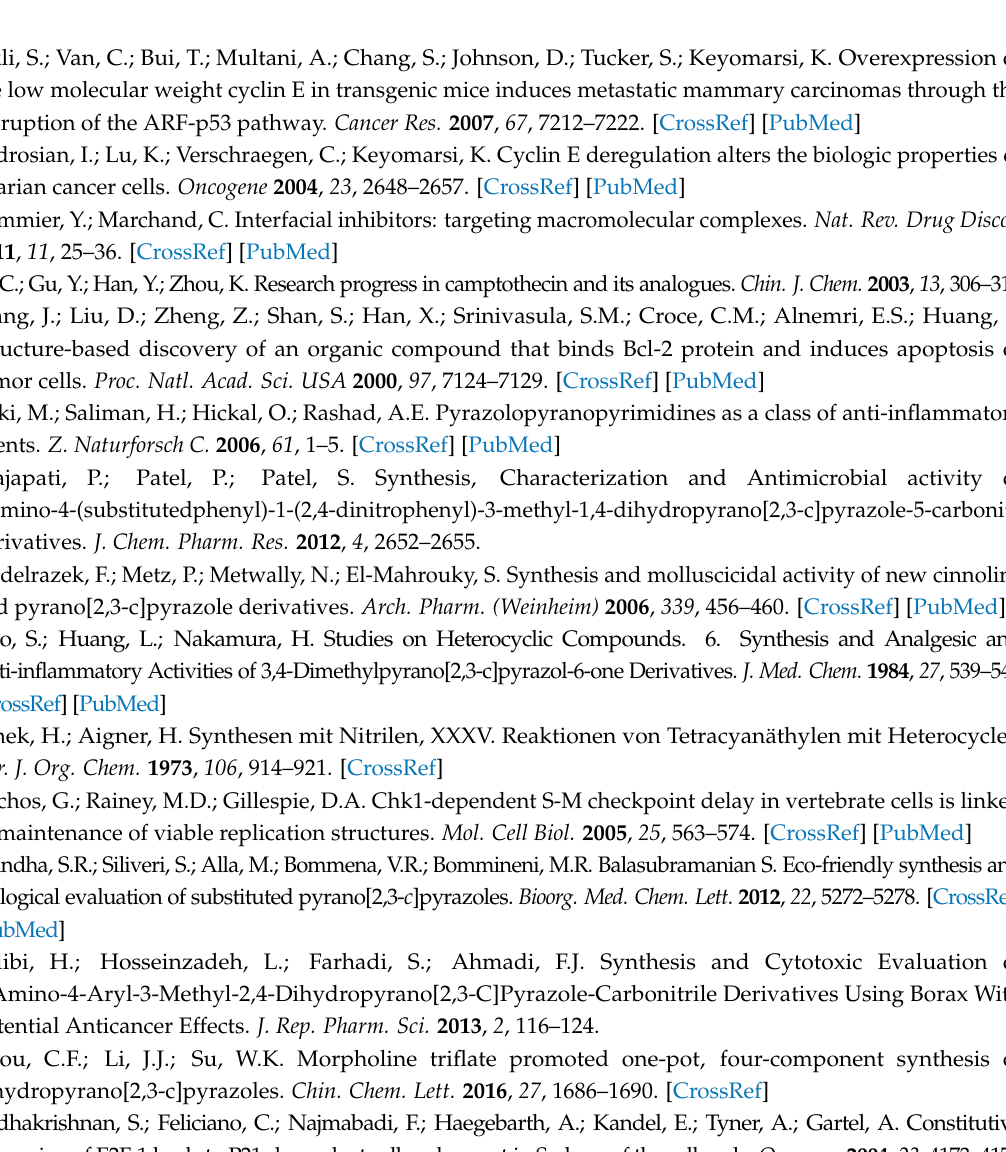
Sample Availability: Samples of the compounds 1–9 (a series of pyrano [2,3-c]pyrazole derivatives) are available from the